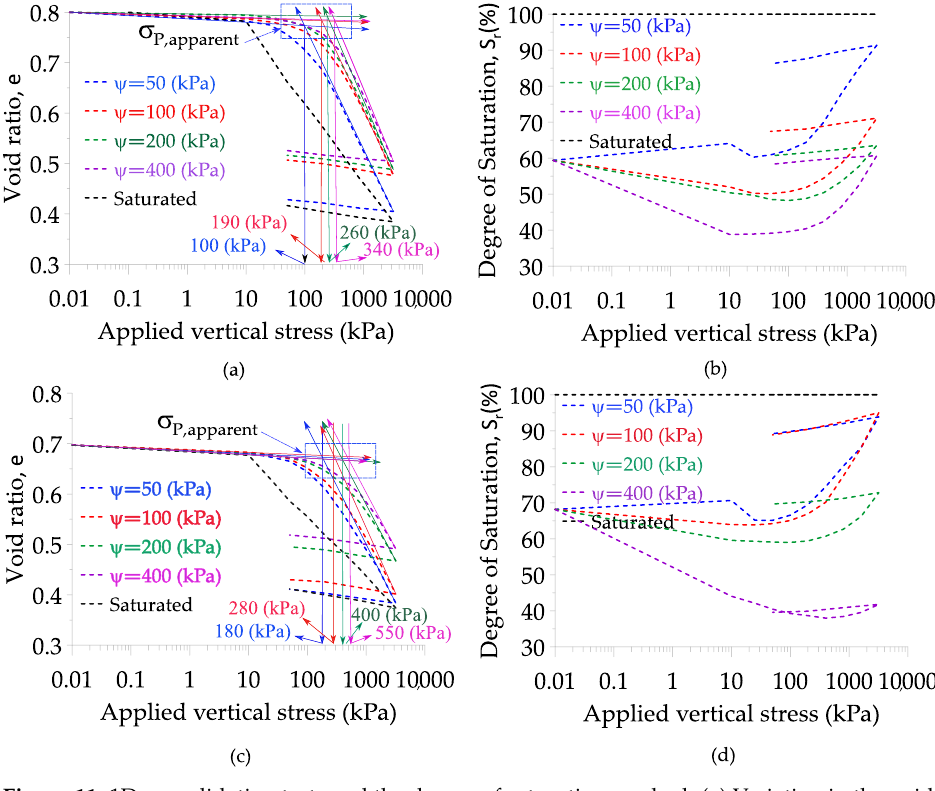
Figure 11. 1D consolidation tests and the degree of saturation reached. ( a ) Variation in the void ratio vs. vertical stress at a dry unit weight of 16.5 kN/m 3 . ( b ) Variation in the void ratio vs. vertical stress at a dry unit weight of 16.5 kN/m 3 . ( c ) Degree of saturation in each increment of vertical stress at a dry unit weight of 17.5 kN/m 3 . ( d ) Degree of saturation in each increment of vertical stress at a dry unit weight of 17.5 kN/m 3